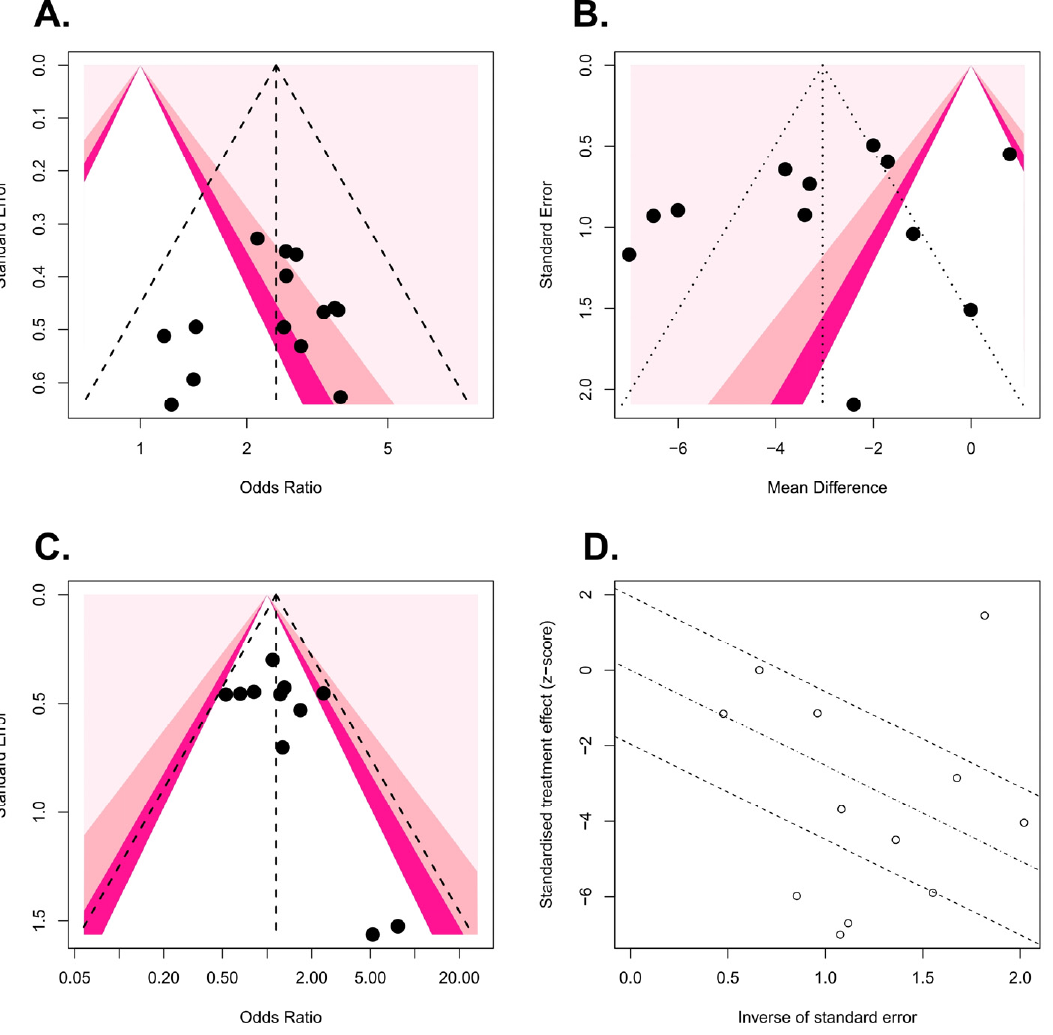
Figure 4. Funnel plots: ( A ) stone expulsion rate, ( B ) stone expulsion time, and ( C ) total complication rate. Radial plot: ( D ) stone expulsion time.